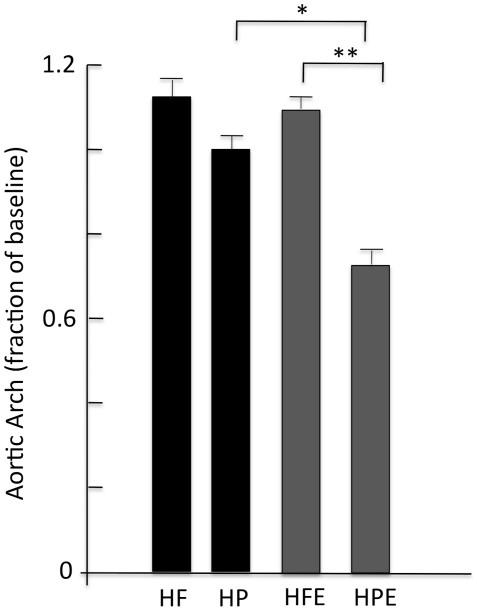
Quantification of aortic arch plaque accumulation in different groups.Aortas were harvested and processed as described in Figure 6 legend and Methods. Plaque in the arches of 8–10 aortas from each group was quantified as described in Methods and expressed as percentages of the baseline plaque at 5-months. Statistics are by 2-way ANOVA as described for Figure 3; *p<0.05; ** p<0.01.